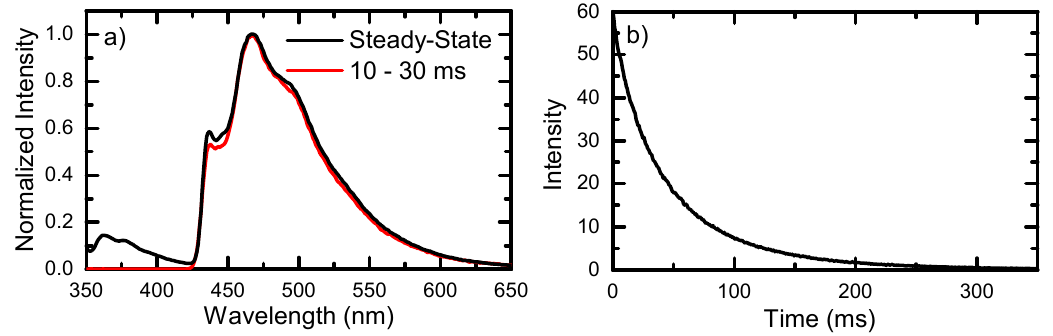
Figure 3. ( a ) Emission spectra of 6tGua in Tris buffer pH 7.4 in frozen matrix at 77 K following steady-state (black) and pulsed (red) excitation at 340 nm. The time-resolved spectrum was recorded 10–30 ms following pulsed excitation; ( b ) Representative phosphorescence decay trace of 6tGua monitored at 480 nm following pulsed excitation at 340 nm in frozen matrix at 77 K.